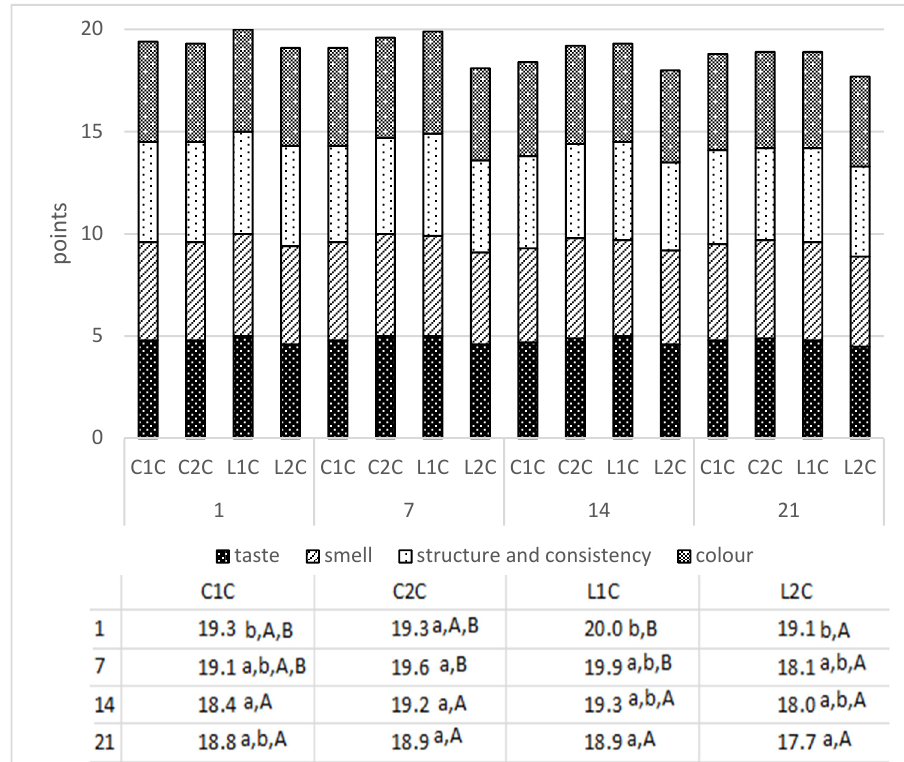
Figure 3. Sensory quality of buttermilk quark cheeses during the storage. C1C—cheese from commercial buttermilk C1B; C2C—cheese from commercial buttermilk C2B; L1C—cheese from laboratory buttermilk with MO 242 culture L1B; L2C—cheese from laboratory buttermilk with MSO culture L2B. Different letters in superscript indicate statistically significant ( p < 0.05) differences between mean values in columns (lowercase letters) and in rows (uppercase letters).